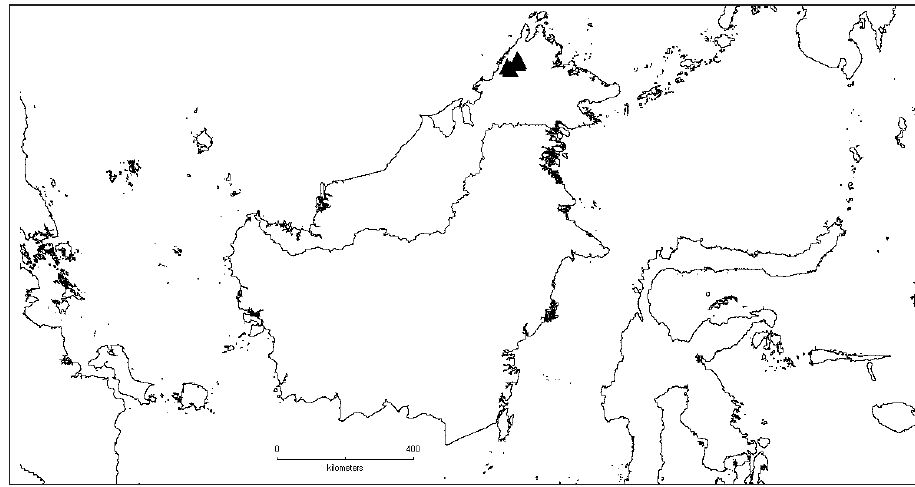
Map 14. Distribution of D. glabra var. kinabaluensis ( ▲